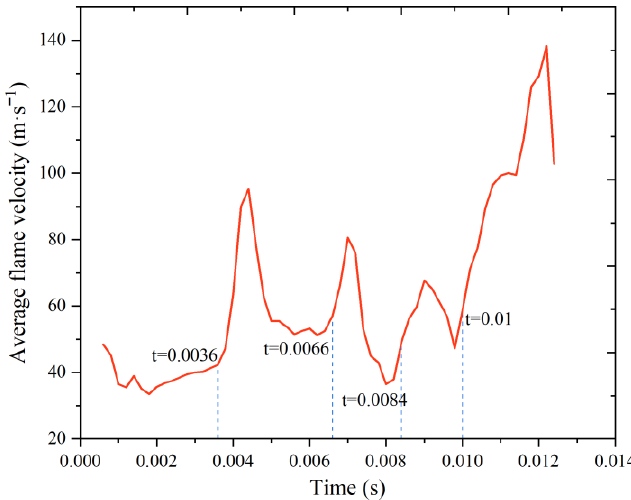
Figure 5. Results of the average flame velocity for the stoichiometric mixture.